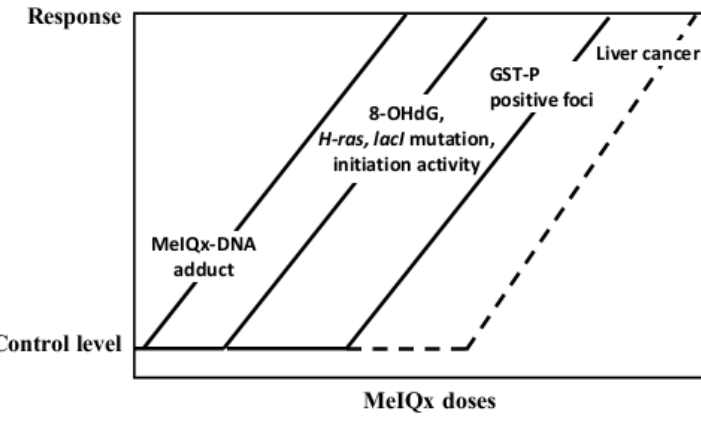
Figure 5. Risk of liver cancer: Reaction curves of the carcinogenicity markers dependent on the dose of